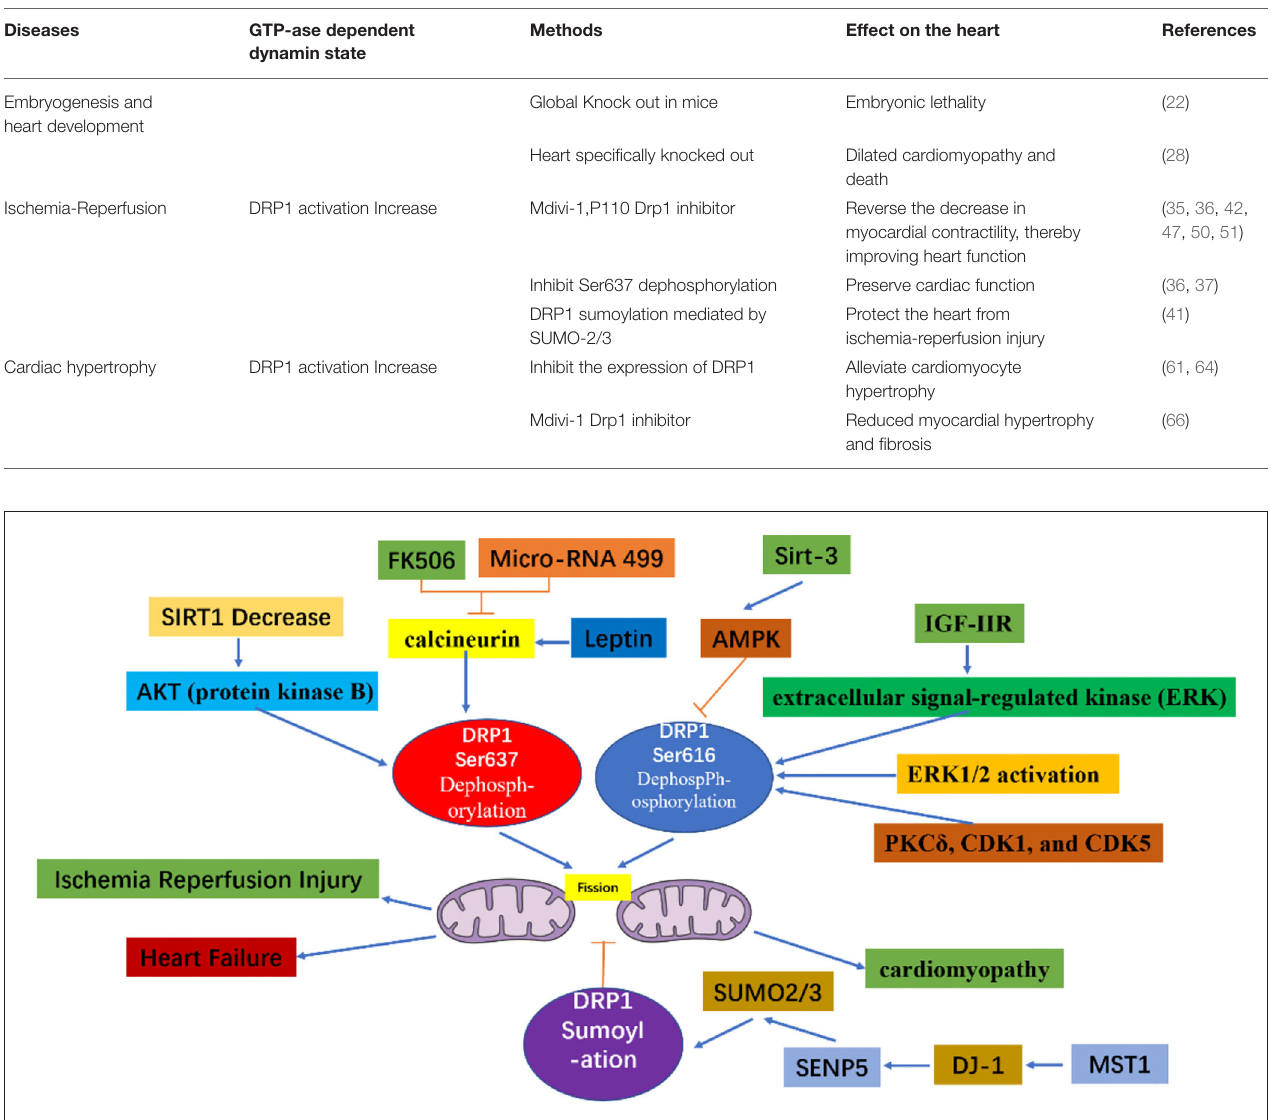
FIGURE 4 | Cell signal transduction pathway acting on DRP1 and its role in heart